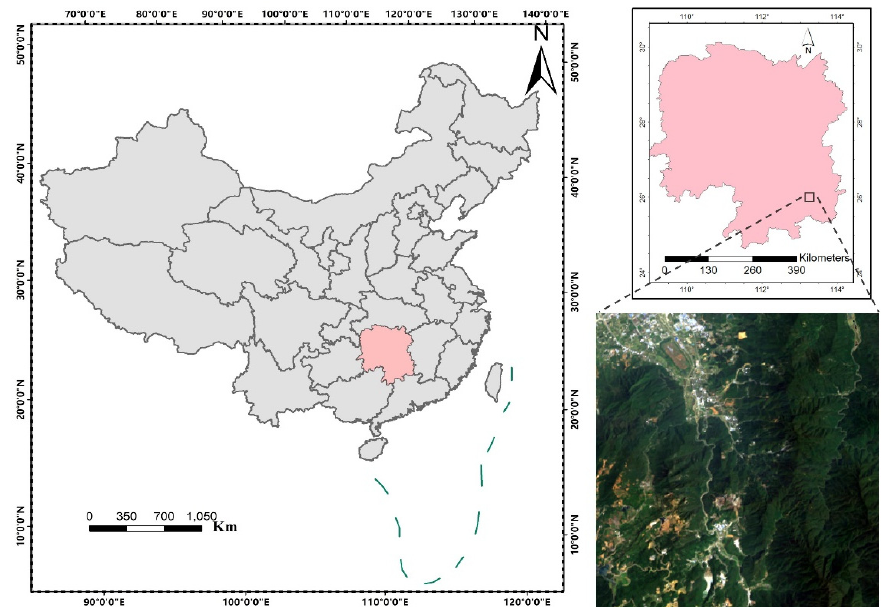
Figure 1. Location of the study area in Hunan Province, China.